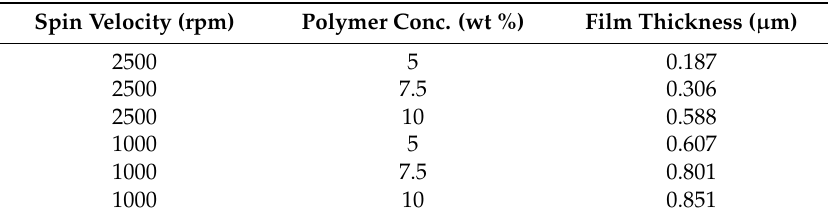
Table 1. Characteristics of dry hydrogel films obtained by spin-coating of the polymer and subsequent photo-cross-linking.